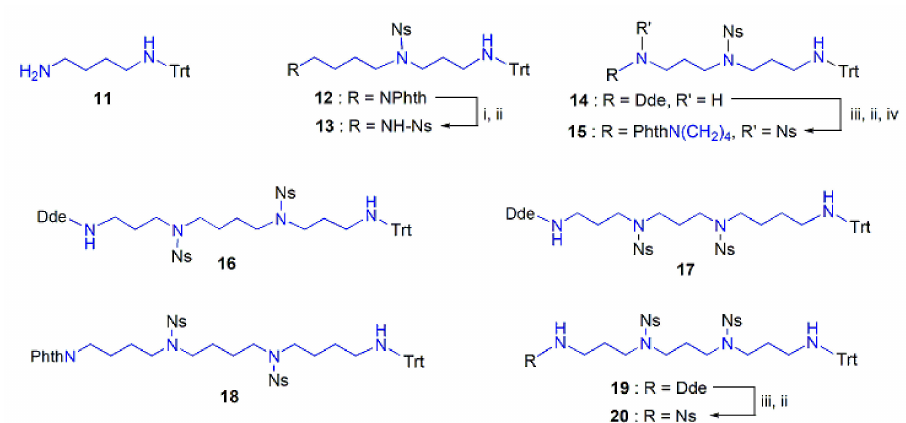
Figure 3. Structures of selectively protected PAs. Reagents and conditions : (i) H 2 NNH 2. H 2 O, EtOH, 78 ◦ C, 2 h, 87%; (ii) NsCl, Et 3 N, DCM, 0 ◦ C, 2 h then 25 ◦ C, 2 h, 62–81%; (iii) 2% Et 2 NH in DMF, 25 ◦ C, 30 min, 72–94%; (iv) PhthN(CH 2 ) 4 Br, K 2 CO 3 , DMF, 60 ◦ C, 2.5 h,